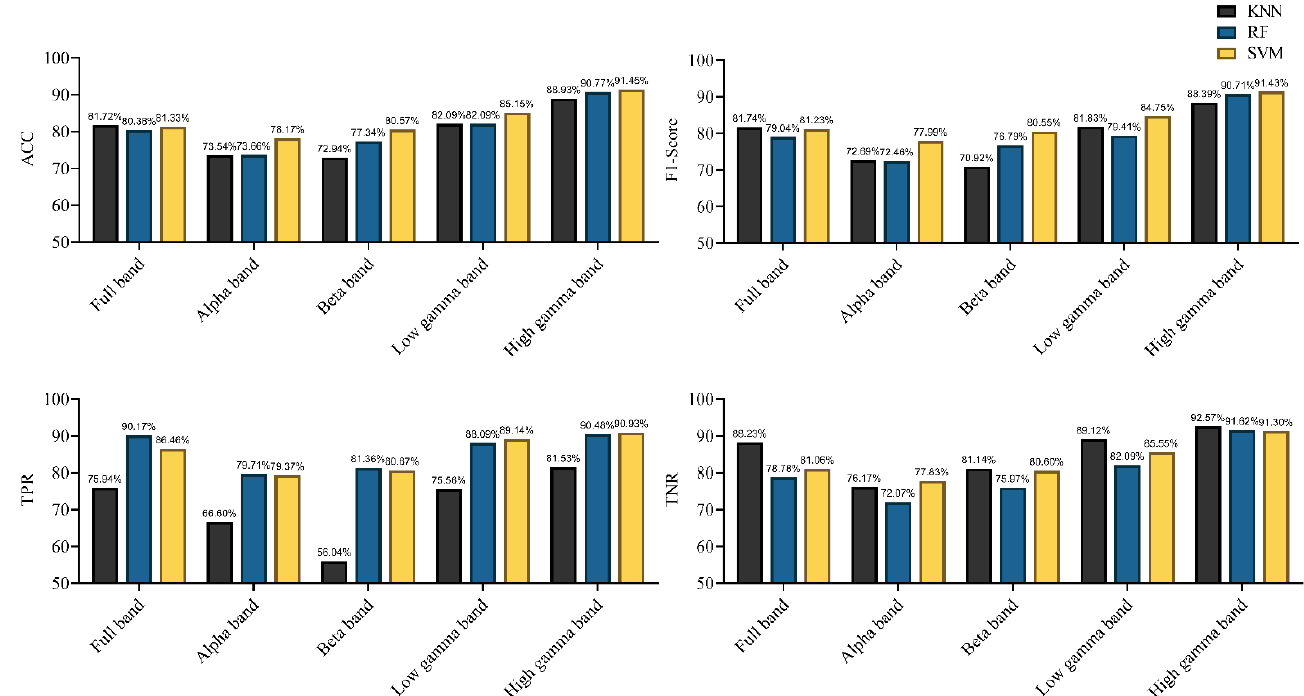
Figure 11. Performance of the different classifiers, characterized by functional directed connectivity in different frequency bands (in terms of ACC, F1-score, TPR, and TNR).